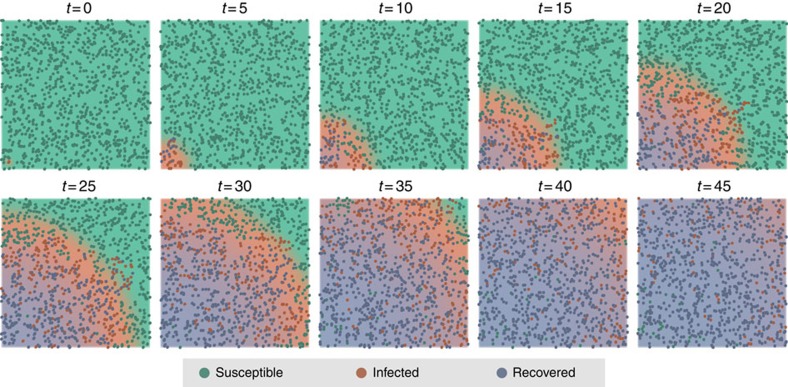
Dynamics of SIRS system.The figure shows the time evolution of a single simulated realization (points) and of the prediction of our method (background colours) for the SIRS system with reactions in equation (10) for time t=0–45, with steps of Δt=5. For the simulation, we use the parameters (Sini,k, w, d, r, s)=(103, 104, 0.02, 0.0002, 0.3, 0.01) and for the point process prediction the corresponding inferred parameters. The background is an RGB image with the three colour components being proportional to the intensity fields of the three species S (turquoise), I (bronze) and R (blue). Notice how the mean-field approximation captures the complex behaviour of a wave of infection, spreading through the domain from the bottom left corner.